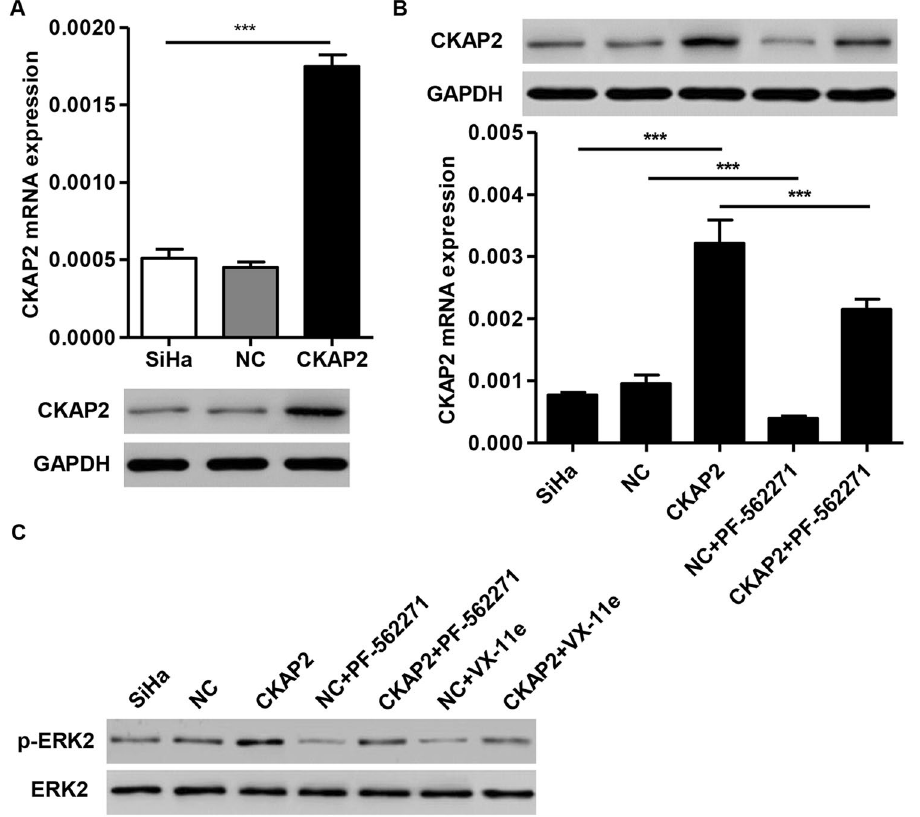
Figure 6. Effects of PF-562271 or VX-11e treatment on CKAP2 and p-ERK2 expression. ( A ) Successful overexpression of CKAP2 in SiHa cells was confirmed by Real-time PCR and Western blot at 48 h after infection with pLVX-Puro-CKAP2 or empty vector. ( B ) SiHa cells were treated with 10 μ M of PF-562271, and the expression of CKAP2 was measured by Real-time PCR and Western blot. ( C ) SiHa cells were treated with 10 μ M of PF-562271 or VX-11e, and the expression of p-ERK2 was measured by Western blot. *** P <